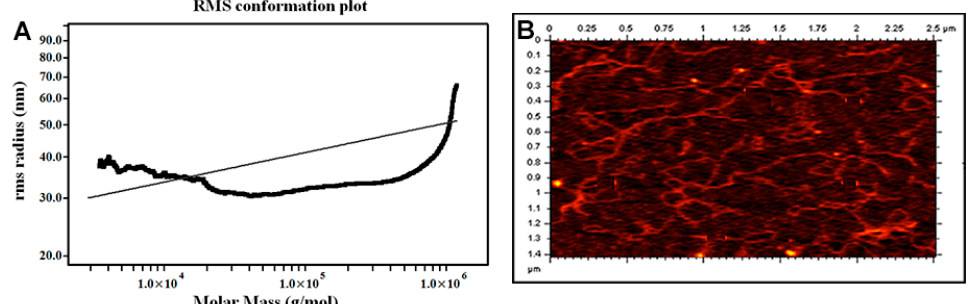
Figure 4. The chain conformation characterization of LeP-N2: ( A ) The plots of < S 2 > z1 / 2 vs. M w in double logarithmic coordinates in a 0.1 M Na 2 SO 4 aqueous solution at 35 °C and ( B ) atomic force microscopy (AFM) images in an aqueous solution.